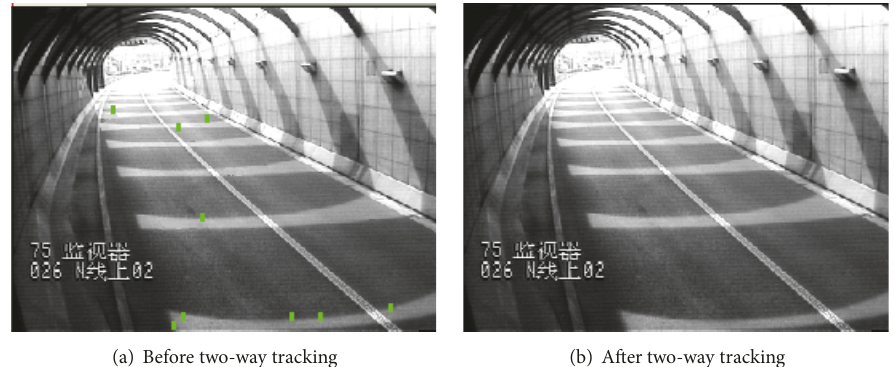
Figure 25: Comparison of abnormal blocks detected before and after bidirectional tracking.